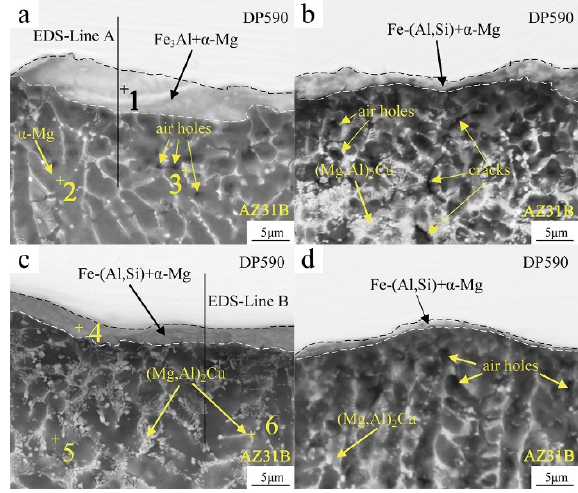
Figure 6. Magnification of magnesium alloy-steel interface: ( a ) magnification of Zone A (Cu − 0%Si), ( b ) magnification of Zone B (Cu − 2%Si), ( c ) magnification of Zone C (Cu − 5%Si), and ( d ) magnification of Zone D (Cu − 8%Si). Table 2. The results of EDS analysis at each point in Figure 6 (at. %).